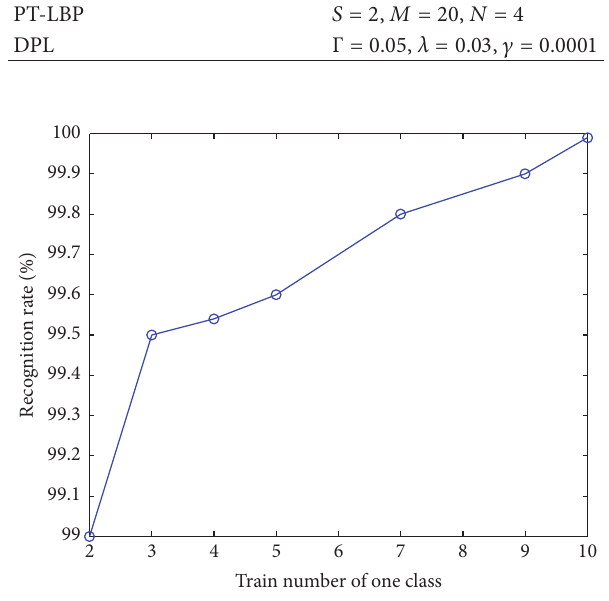
Figure 5: Recognition rates by different training number.